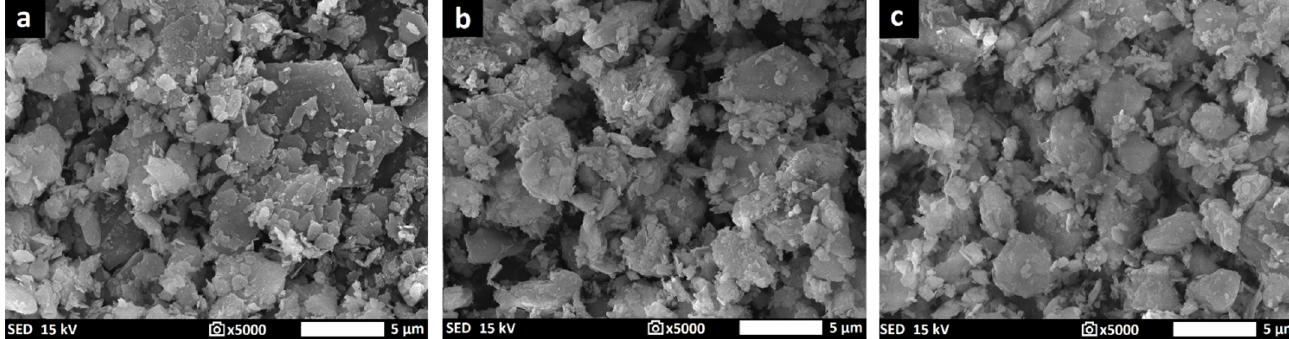
Figure 2. The morphology of M1 ( a ), M2 ( b ) and M3 ( c